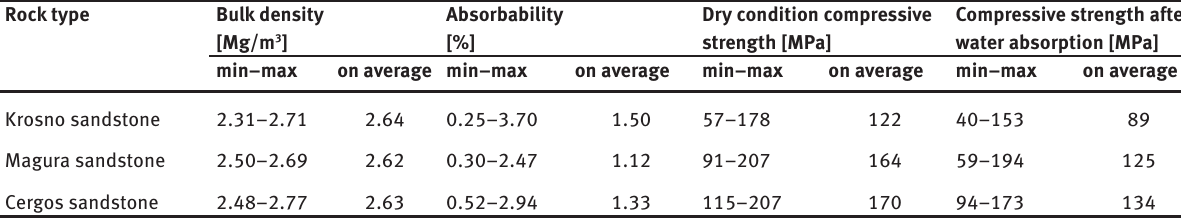
Table 1: Physico-mechanical properties of sandstones [12]. Rock